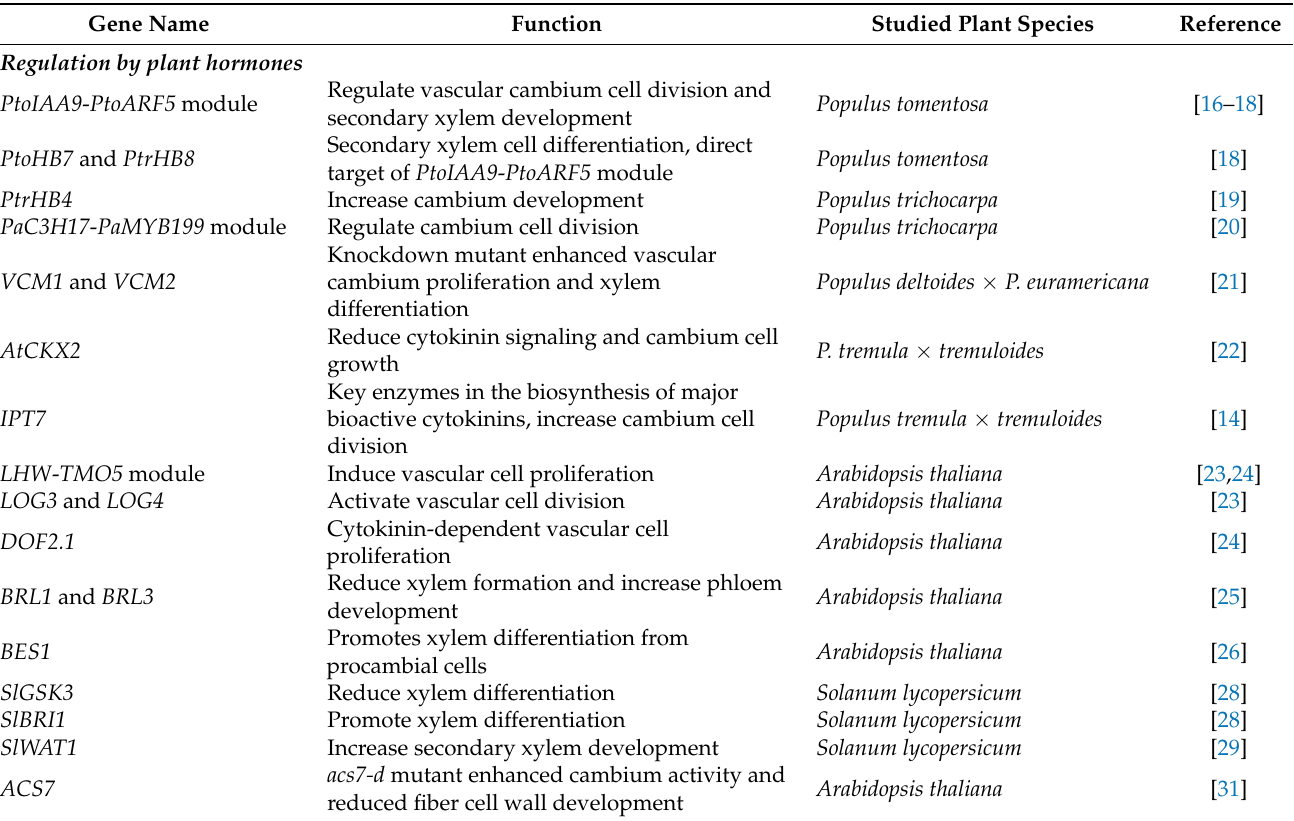
Table 1. Summary of recent wood formation